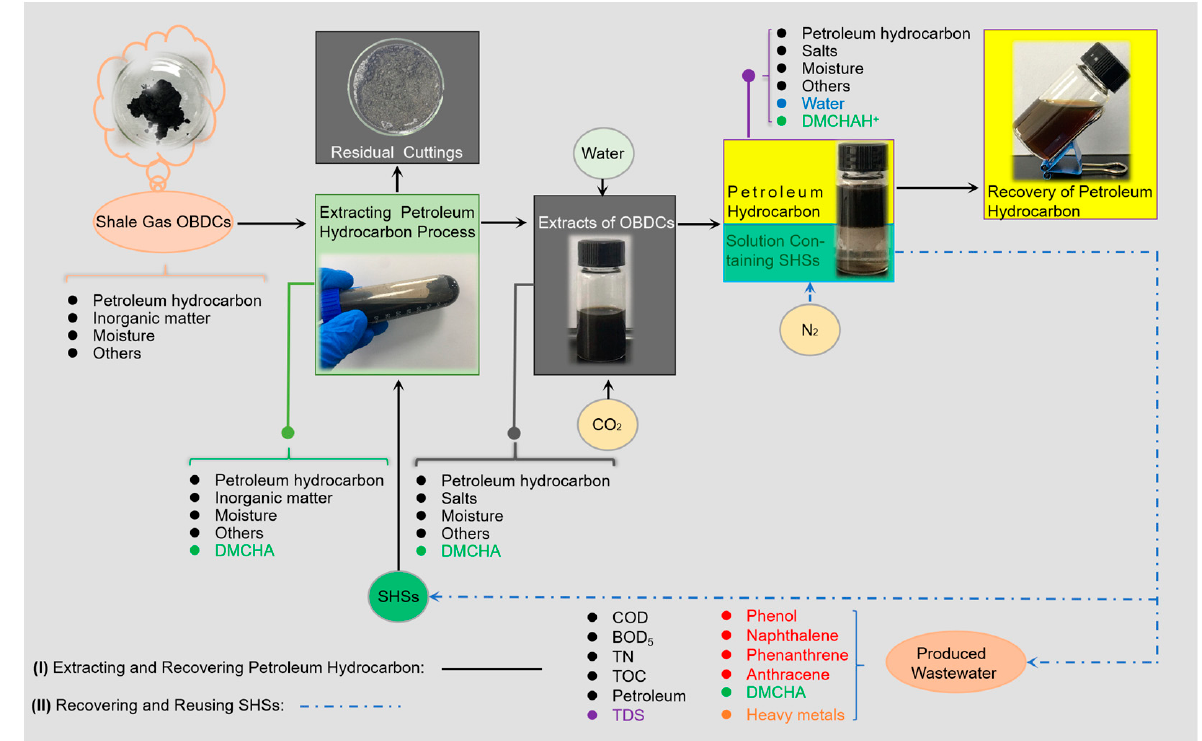
Figure 12. A possible priority pollutant migration mechanism during treatment of ODBCs by using CO 2 SHSs.